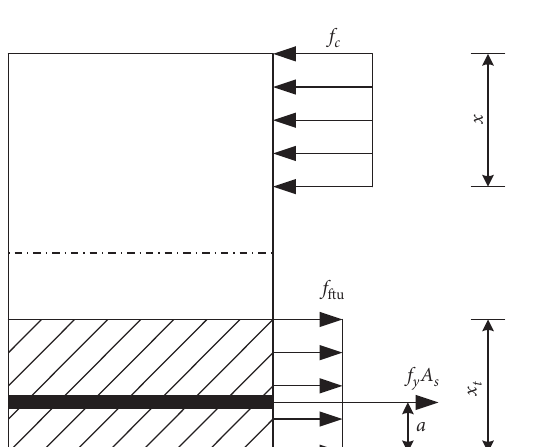
Figure 16: Typical crack distribution diagrams.